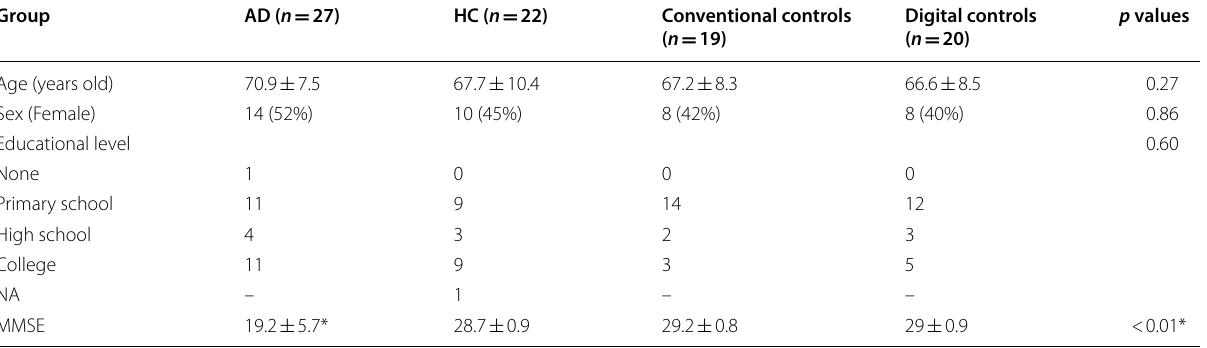
Table 1 Characteristics of the Alzheimer’s disease patients, healthy control subject’s as well as the conventional and digital control